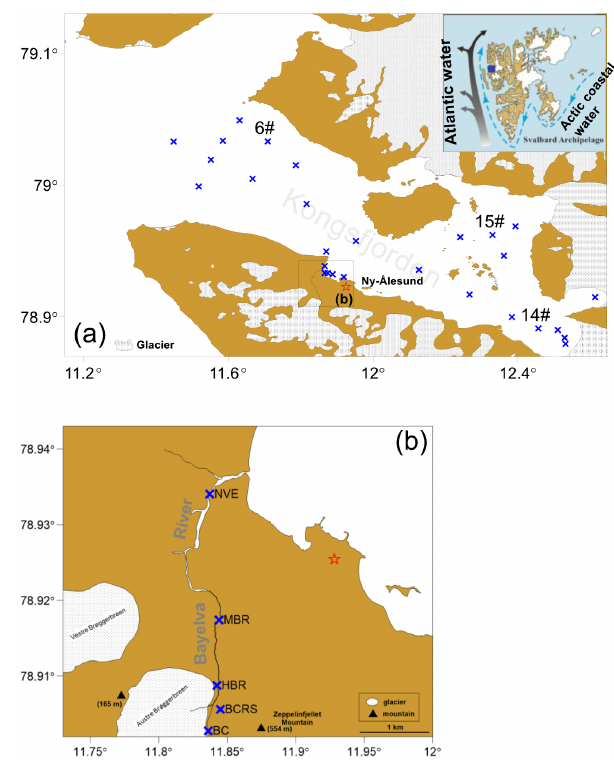
Figure 1. Study area and sampling stations in (a) the Kongsfjorden and (b) the Bayelva River in August 2012 (red star indicates the location of Ny-Ålesund; a schematic of the glaciers is shown as inset in panel a